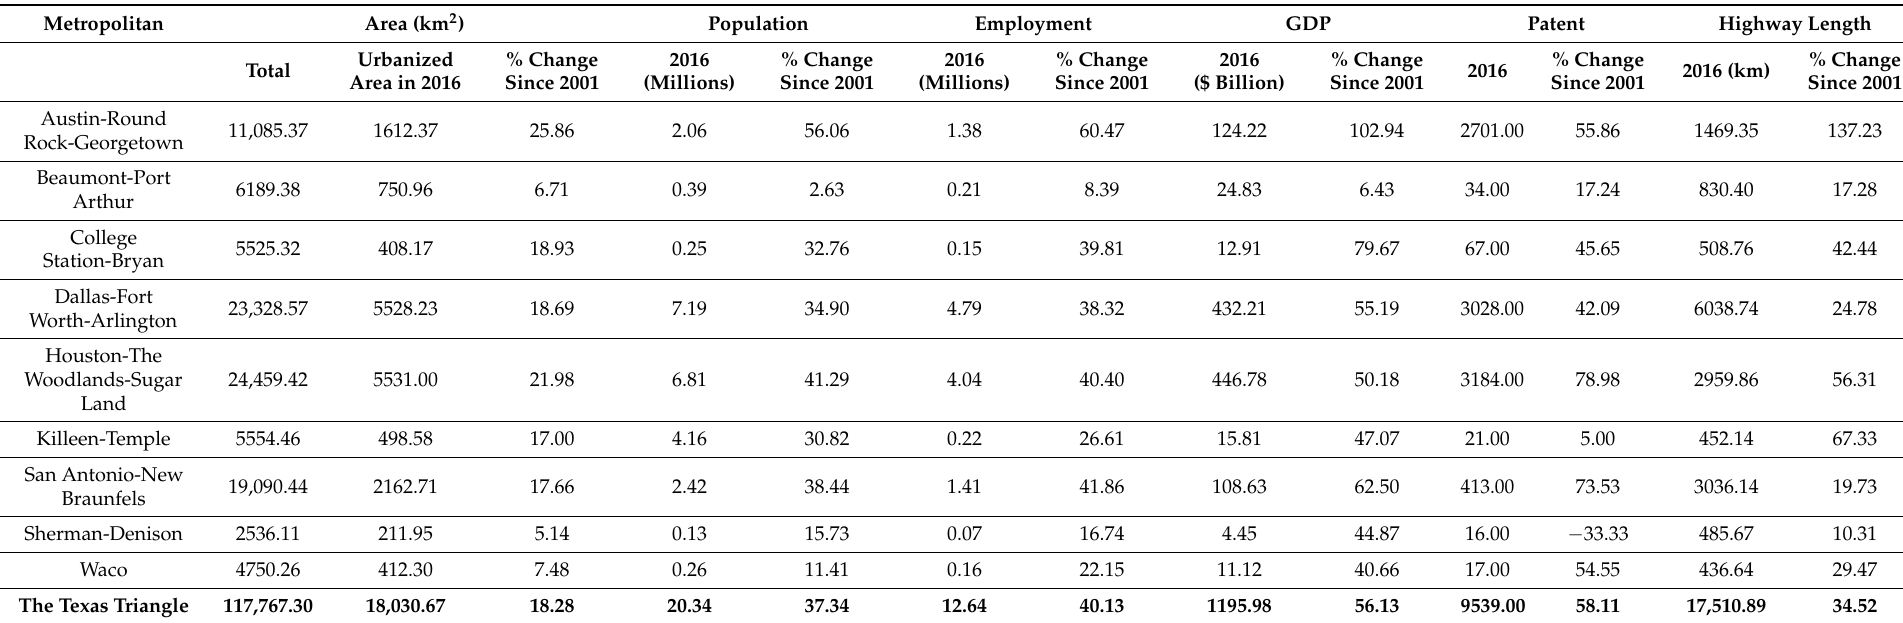
Table 1. Descriptive data in the Texas Triangle,